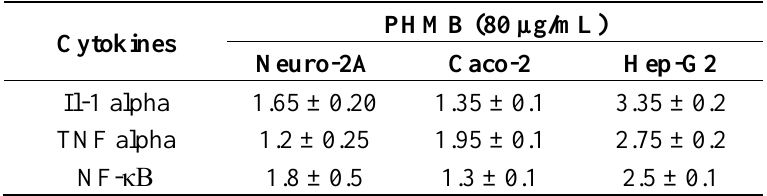
Table 13. Quantification of (interleukin 1 alpha, TNF alpha and nuclear factor kappa B) in the cellular homogenate, following 24 h incubation with PHMB (80 µg/mL). The cytokines were quantified using different ELISA kits.